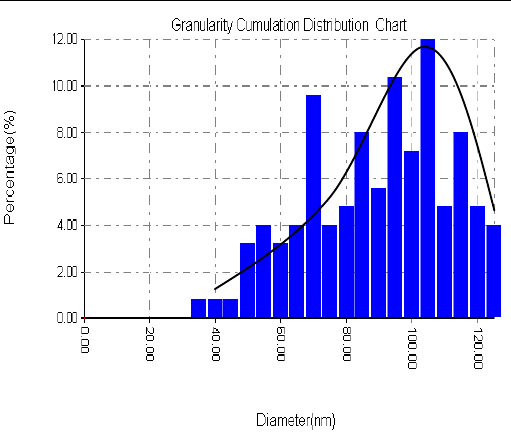
Fig.6a: UV-Vis absorption spectra of nanoparticles colloid fabricated at wavelenght CdTe ablated with 620mJ at 1064nm.